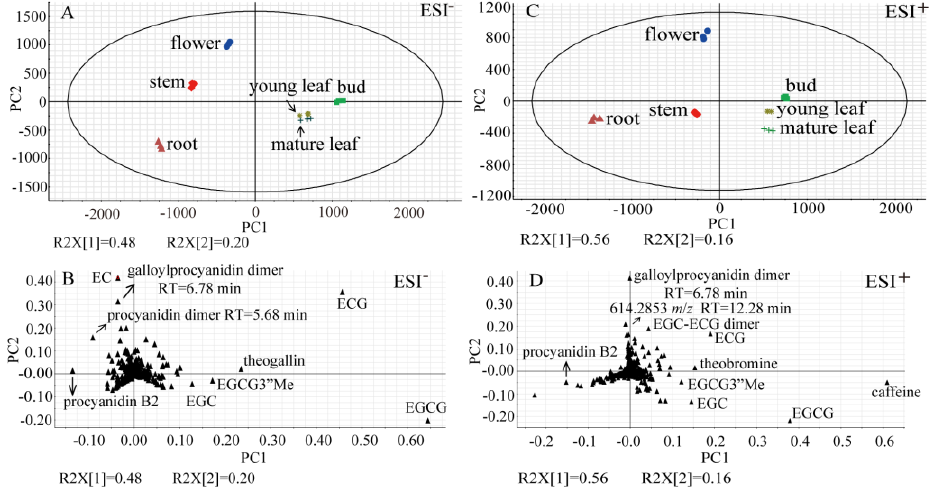
Figure 2. Metabolic profiles of tea tissue samples demonstrated by PCA score plots and PCA loading plots. ( A ) PCA score plot for tea tissue samples based on 732 single molecular features detected in ESI − . ( B ) PCA loading plot showing major metabolites that contribute to group separation in ESI − . ( C ) PCA score plot for tea tissue samples based on 821 single molecular features detected in ESI + . ( D ) PCA loading plot showing major metabolites that contribute to group separation in ESI + . R2X, explained variation. PC1, the first principal component. PC2, the second principal component. For each tissue type, three biological replicates were prepared, where one replicate was a pool of collected materials from three tea plants.